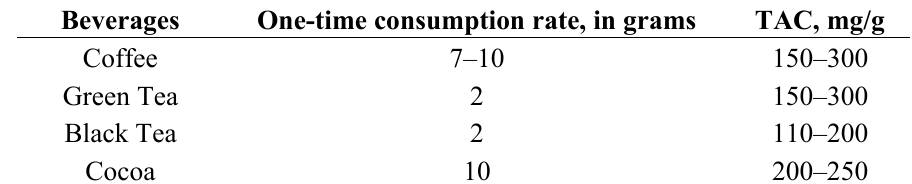
Table 2. Total antioxidant content of different beverages. Note: Natural roasted coffee produced by the Madeo Company. Best grades of green and black tea purchased in the stores. (Averaged values of TAC)